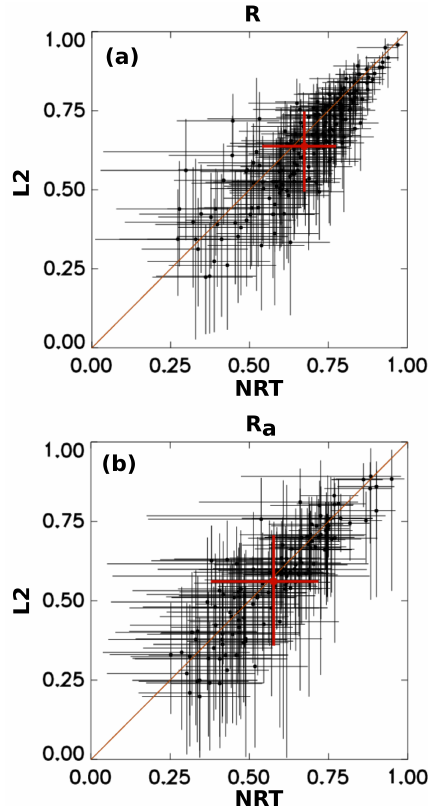
Figure 6. (a) Scatter plots showing the Pearson correlation coeffi- cient of the NRT and L2 SM time series with respect to the in situ measurements ( R ). The error bars account for the 95% confidence intervals. The red symbols represent averaged values. (b) Same as (a) but for the anomalous time series ( R a